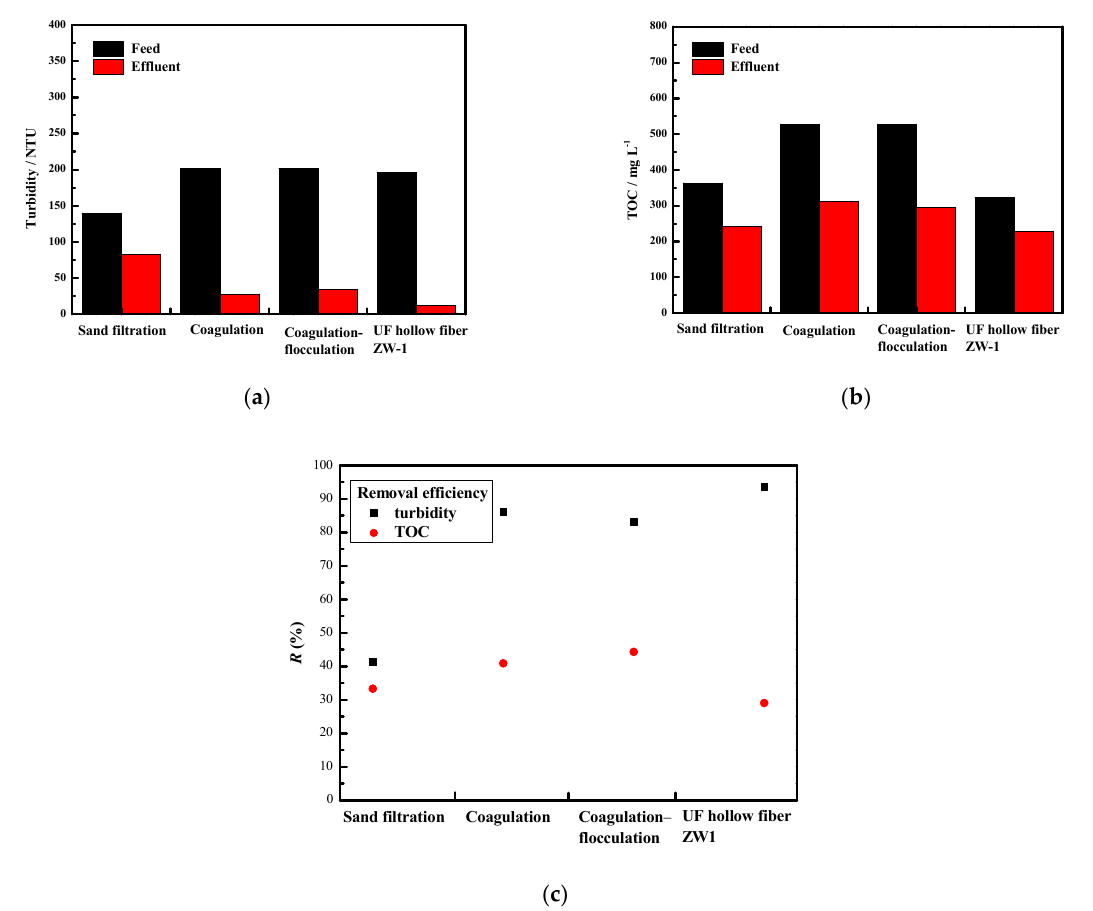
Figure 1. Concentration of ( a ) turbidity and ( b ) TOC in real TWW (feed) and investigated pretreatment effluents with ( c ) removal efficiency ( R ).